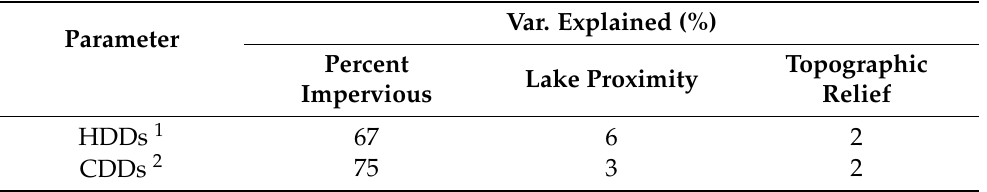
Table 4. Percent of spatial variation explained by three influencing factors for spring 2012 to spring 2015 averages of heating and cooling degree days in Madison, Wisconsin, USA